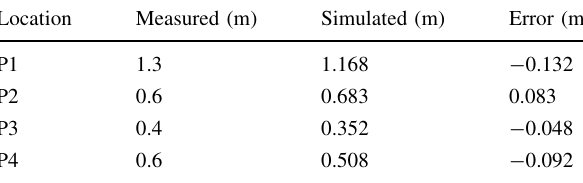
Table 2 Validation of the simulation results and the measured